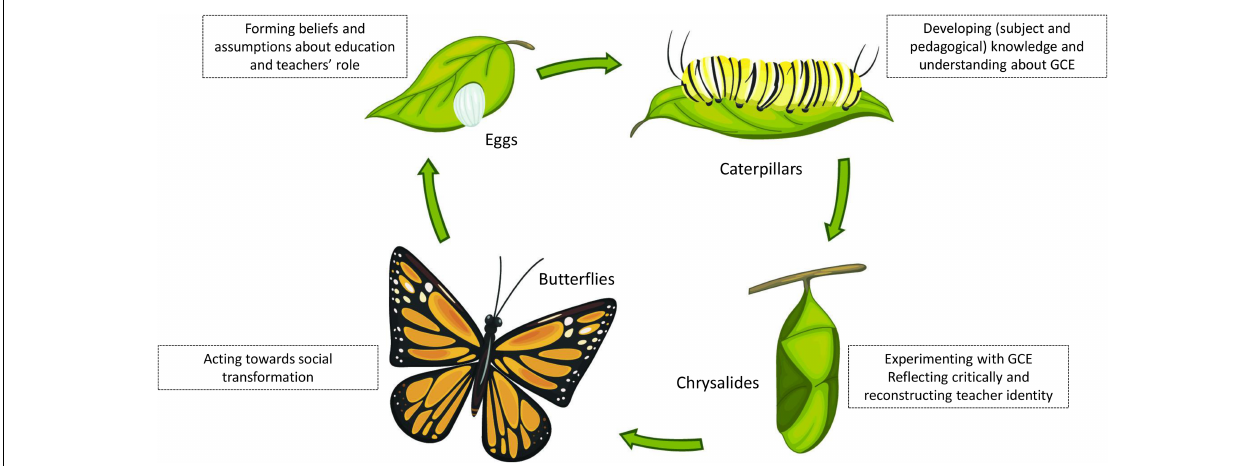
FIGURE 1 | A framework for analyzing PSTs’ pathways towards GCE.